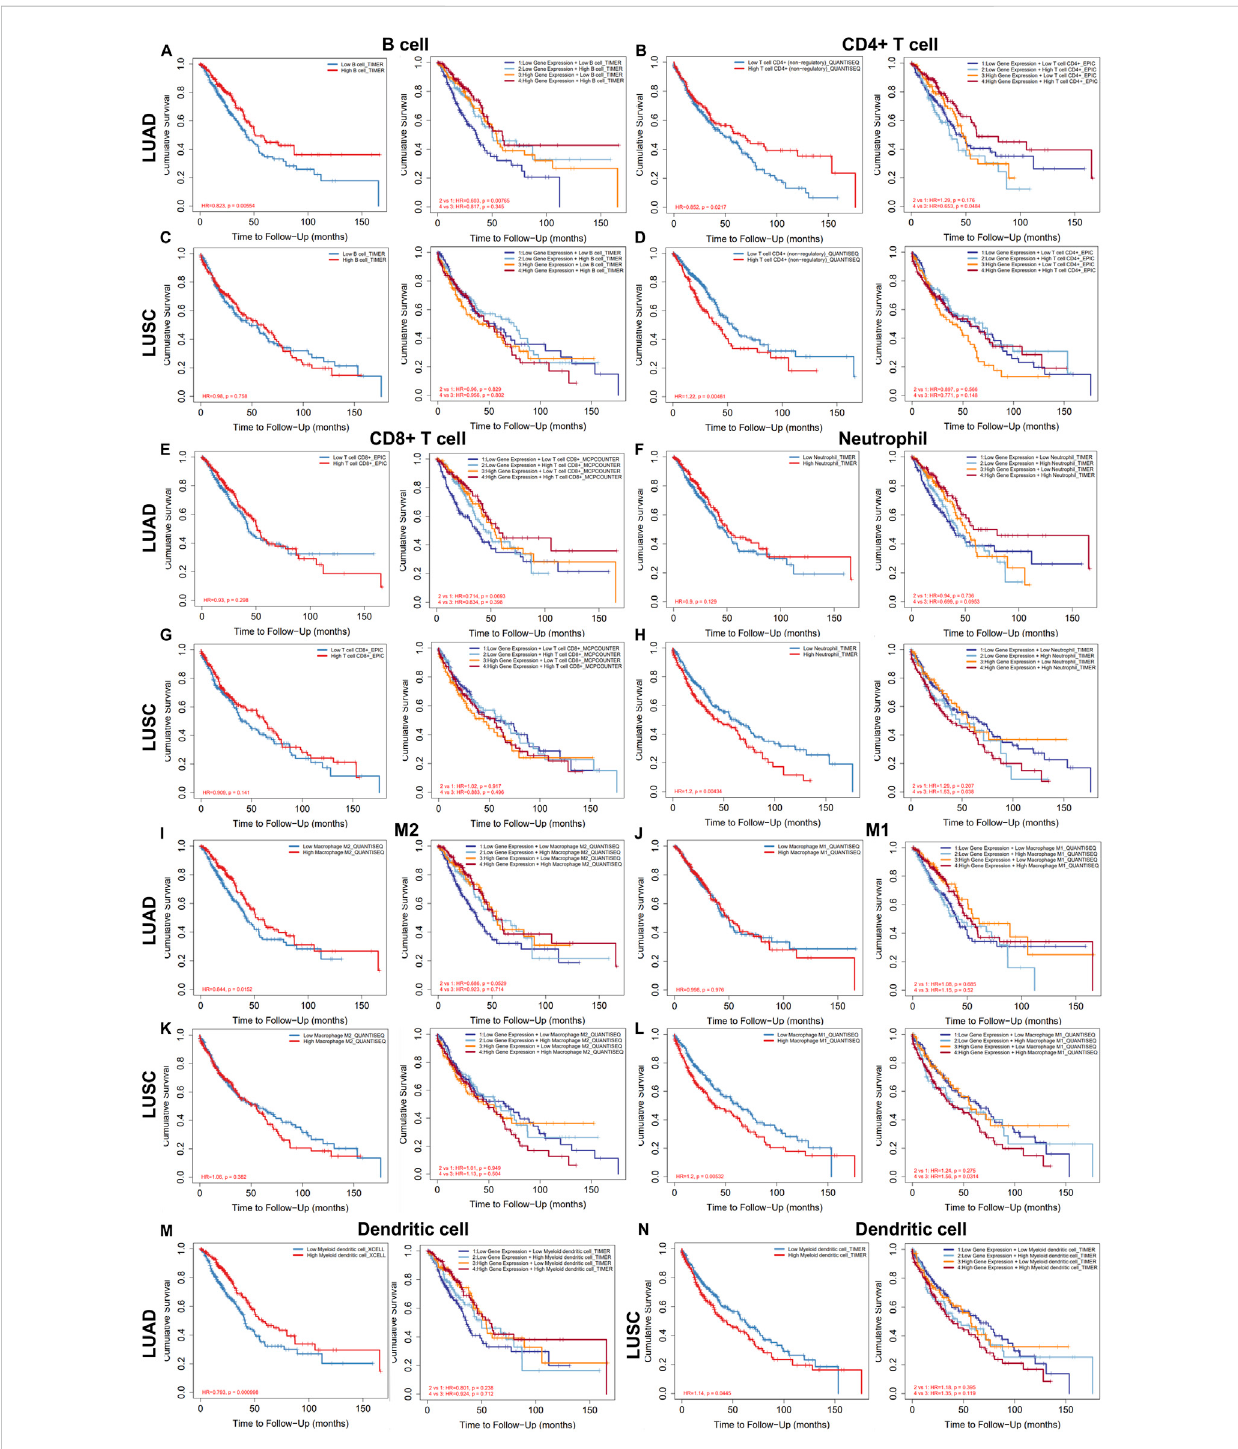
FIGURE 6 Relationship between the level of immune in fi ltration and OS and its synergy with TMPRSS2 expression in LUAD and LUSC by using TIMER 2.0. Including B cell (A,C) , CD4 + T cells (B,D) , CD8 + T cells (E,G) , neutrophils (F,H) , M2 (I,K) , M1 (J,L) and dendritic cell (M,N) .